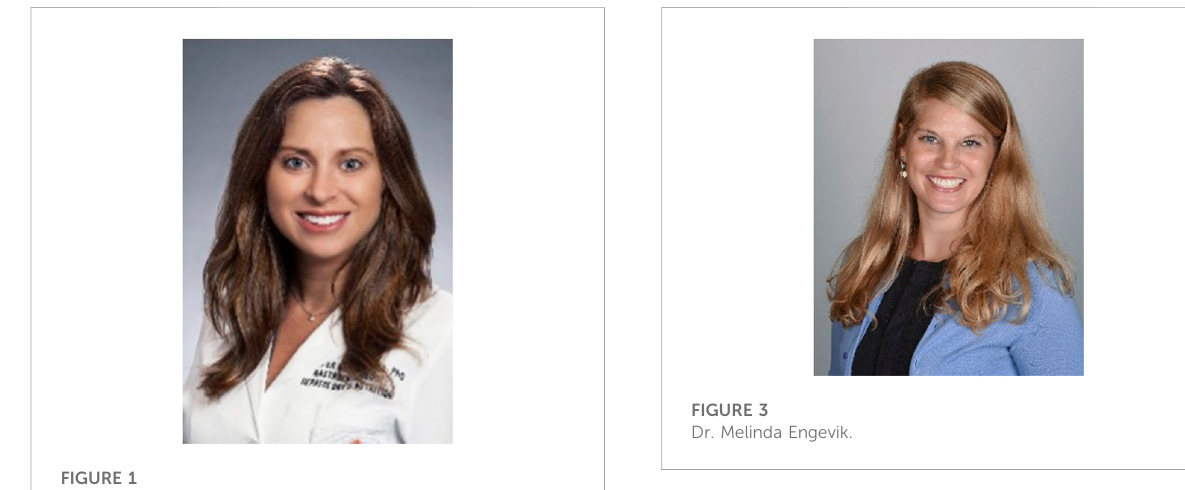
FIGURE 1 Dr. Jennifer Bailey-Lundberg.